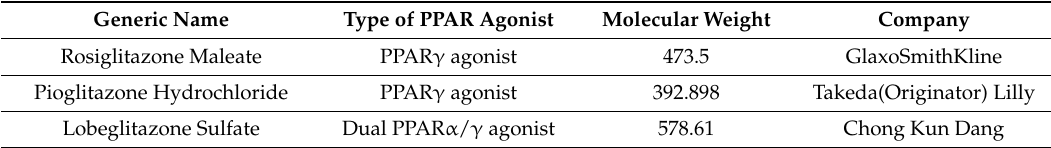
Table 2. Approved drugs of PPAR ligands for type 2 diabetes treatment.